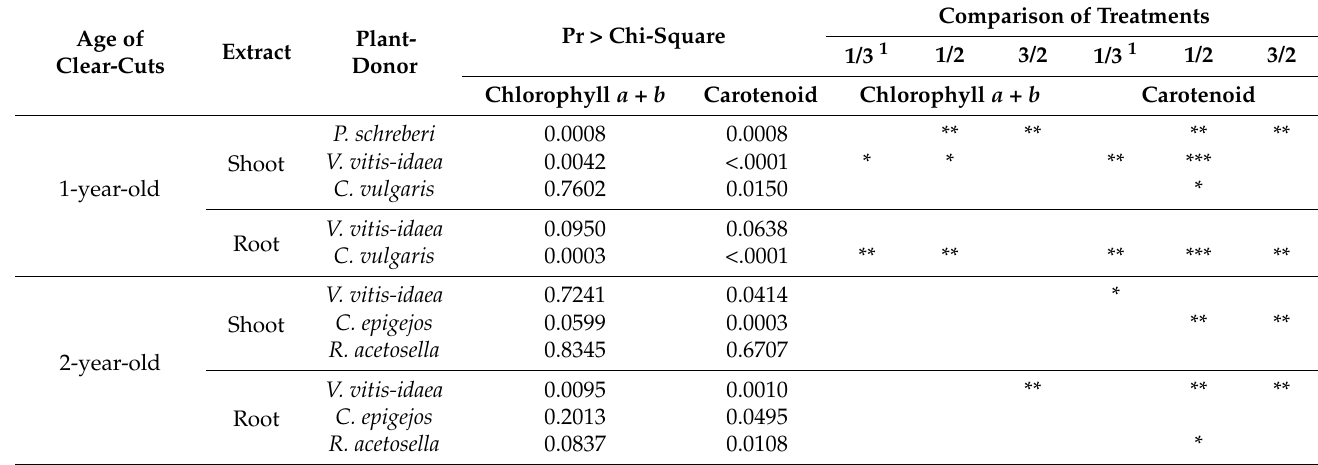
Table 3. Overall difference between treatment groups and between the treatments ( n = 9) for chlorophyll (mg g − 1 ) and carotenoid (mg g − 1 ) concentrations under different climate conditions (* p < 0.05, ** p < 0.01, *** p < 0.001). Age